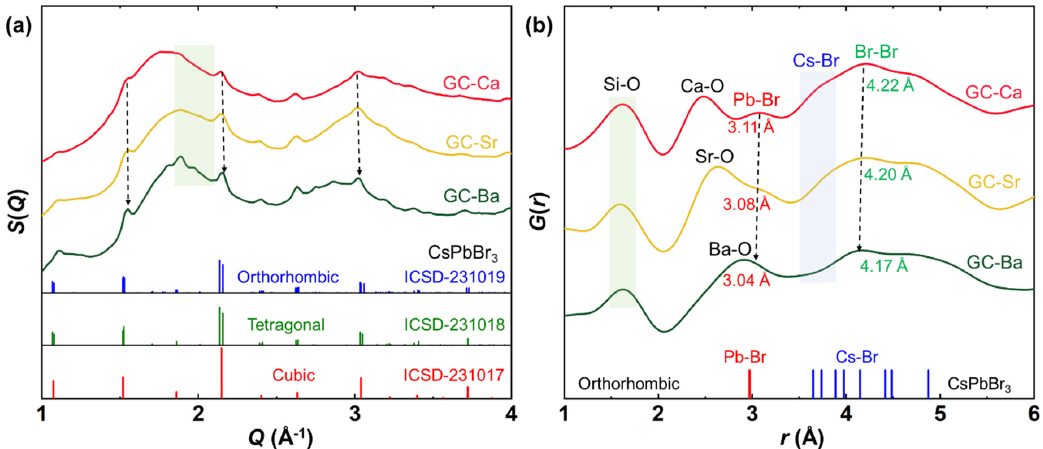
Figure 5. ( a ) High-resolution structure factor S ( Q ) and ( b ) the pair distribution function (PDF) curves G ( r ) of GC-Ca, GC-Sr, and GC-Ba at room temperature (where Q is the X-ray scattering vector).